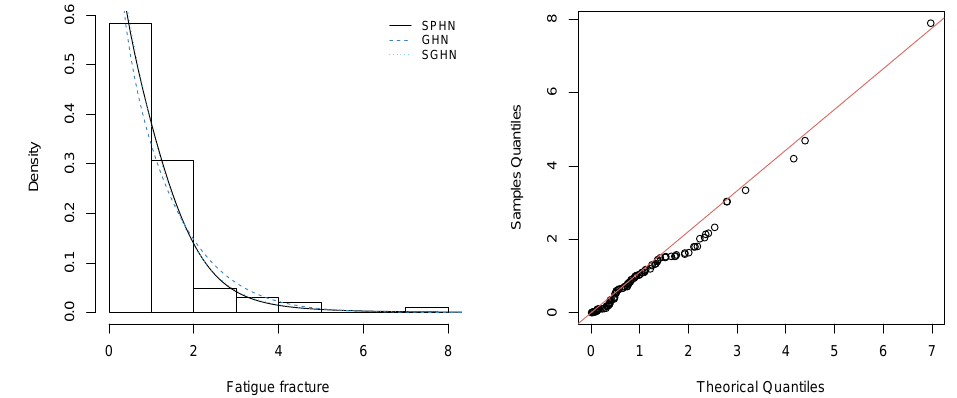
Figure 7. Left panel: Histograms of the fatigue fracture data fitted with the GHN, SGHN and SPHN distributions. Right panel: QQ plot for the SPHN distribution.